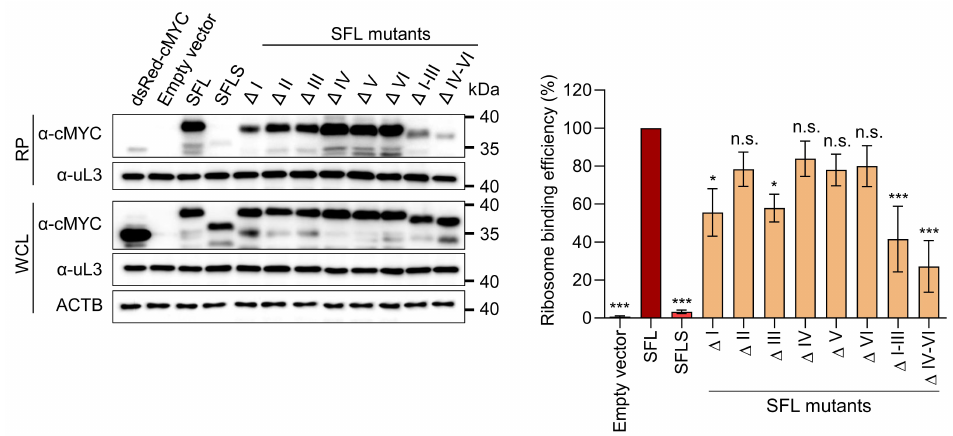
Figure 6. Effect of RAA deletions on ribosome binding. HEK293T cells were transfected with plasmids encoding SFL, SFLS, and the indicated SFL variants equipped with a C-terminal MYC antigenic tag. At 48 h post-transfection, cells were lysed and WCL was loaded on a sucrose cushion and centrifuged for 60 min at 100,000 rpm at 4 °C. The ribosomal pellet (RP) and WCL were analyzed by immunoblot using anti-MYC antibody. The large ribosomal subunit protein uL3 served as a loading control. A representative blot is shown in the ( left panel ); irrelevant lanes were excised. Up to five replicates were quantified by the software ImageJ, and the cMYC signals in RP and WCL were normalized against the corresponding uL3 signals and the ratio of cMYC signals in RP versus WCL was calculated ( right panel ). The ratio obtained for SFL was set as 100%. The average of four (mutants ΔI, ΔII, ΔIII, ΔIV, ΔV, ΔVI) or five (SFL, SFLS, Δ I–III, Δ IV–VI) independent experiments is shown; error bars indicate standard error of the mean (SEM). One-way analysis of variance (ANOVA) with Dunnett’s multiple comparison test was performed to determine whether differences between cells expressing SFL, SFLS, SFL mutants, or empty vector were statistically significant (not significant [n.s.]; *, p ≤ 0.05; ***, p ≤ 0.001; n = 5). SFL, shiftless; SFLS, shiftless short; WCL, whole cell lysate.